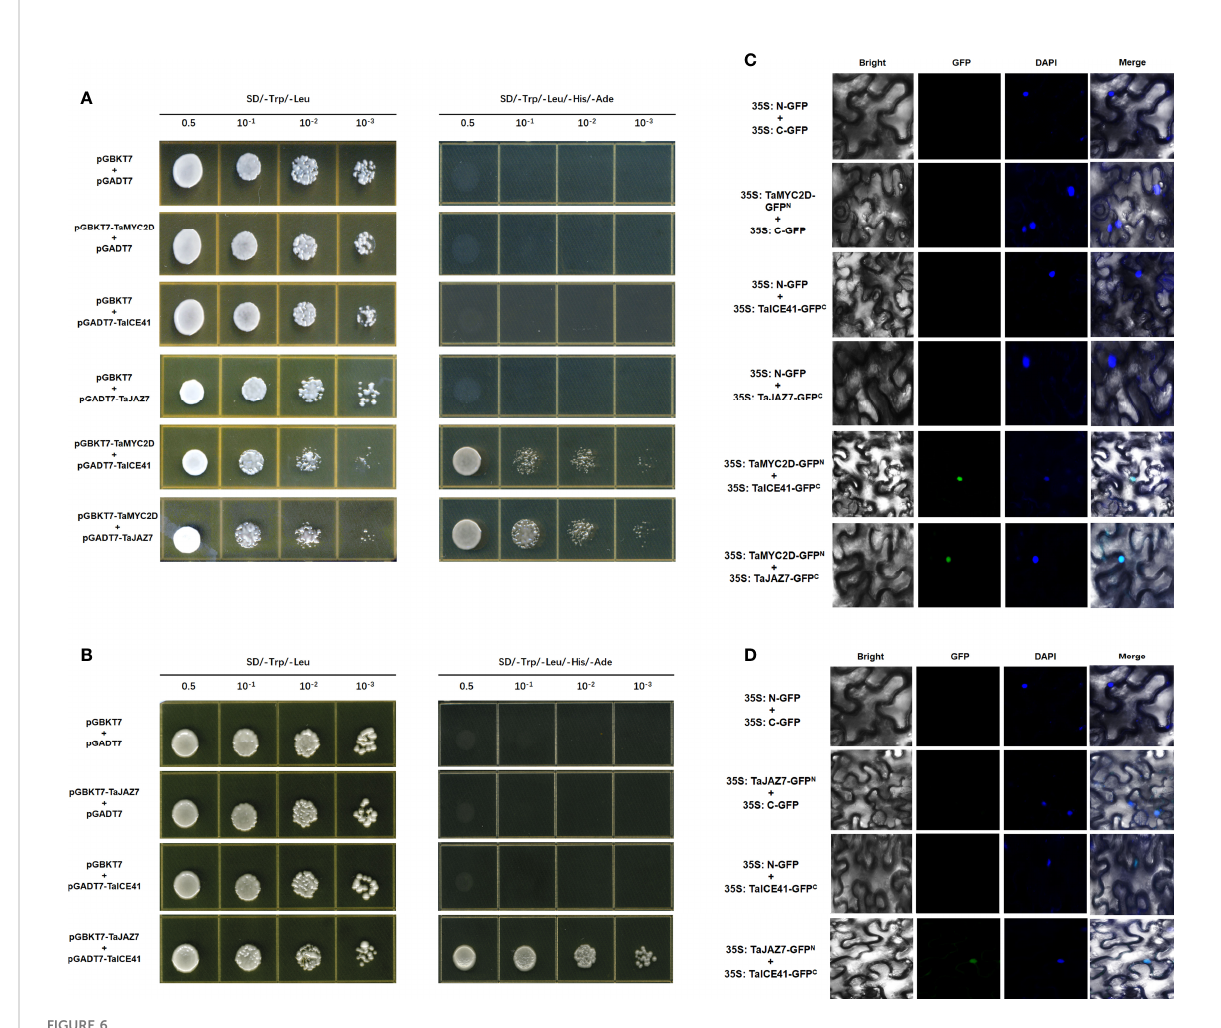
FIGURE 6 Protein interacts with protein. TaMYC2D protein physically interacts with TaICE41 and TaJAZ7 protein. (A) Y2H and (C) BiFC analysis. TaJAZ7 protein physically interacts with TaICE41 protein. (B) Y2H and (D) BiFC